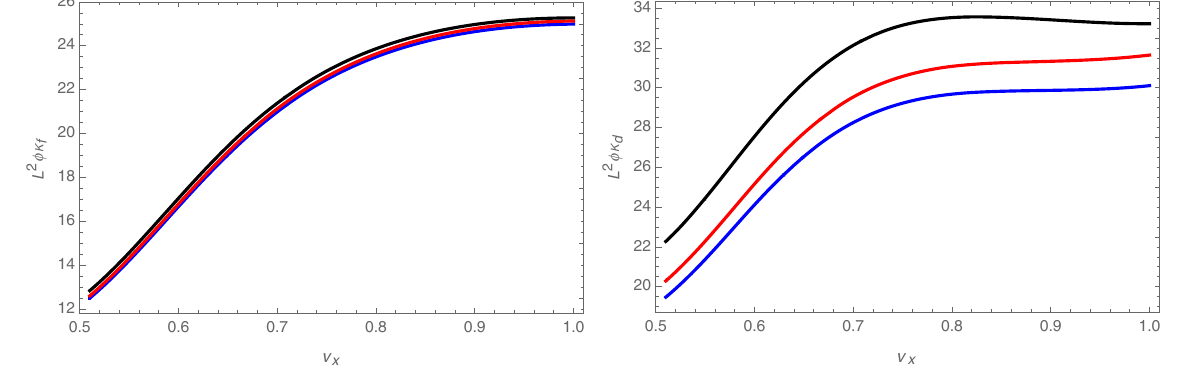
FIG. 10. The settings of focusing (left) and de-focusing (right) sextupoles as a function of the betatron tunes with various ratios: ν ∶ ν 1 ∶ 4 , 1:3, and 1 ∶ 2 represented by blue, red, and black color respectively. y x ¼